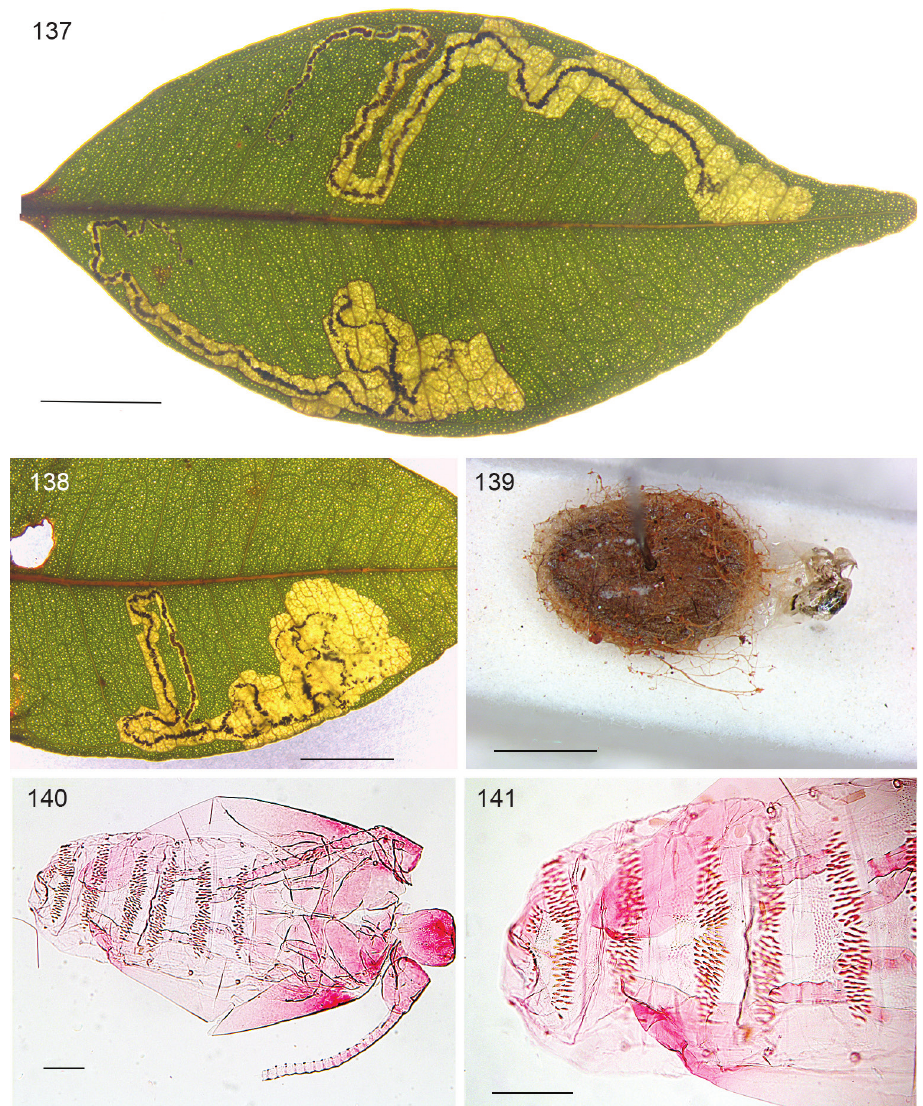
Figures 137–141. Hesperolyra saopaulensis , biology and immatures. 137–138 leafmines on unidentified Myrtaceae, sample EvN2000133K from which both adults were reared 139–141 Holotype cocoon and pupal exuviae, slide EvN3553. Scales: 5 mm (leaf mines), 1 mm (cocoon), 200 µm (pupa).